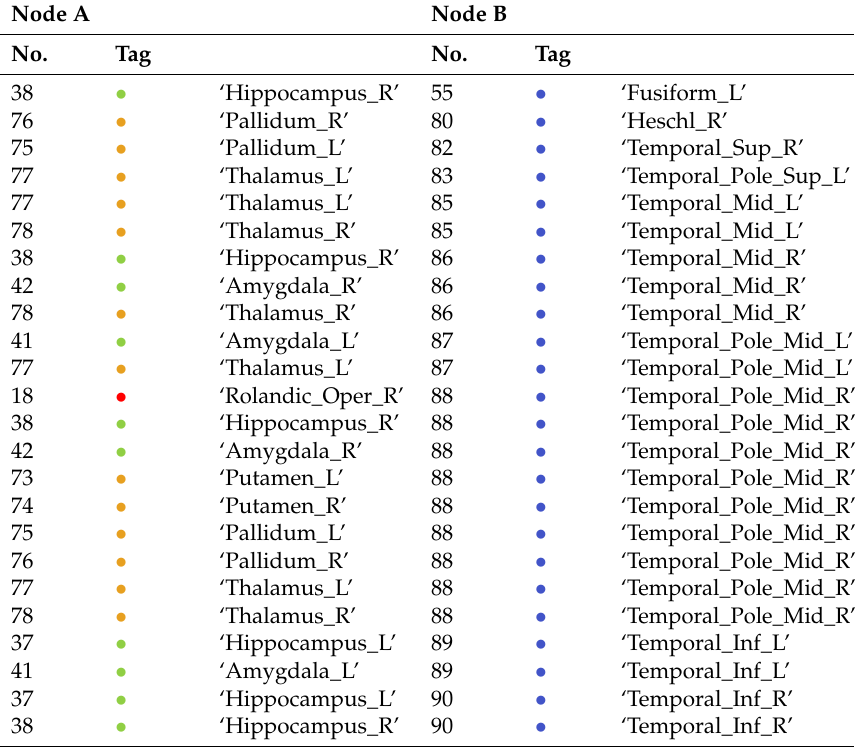
Table A1. List of the 24 links comprised in the overconnectivity network.